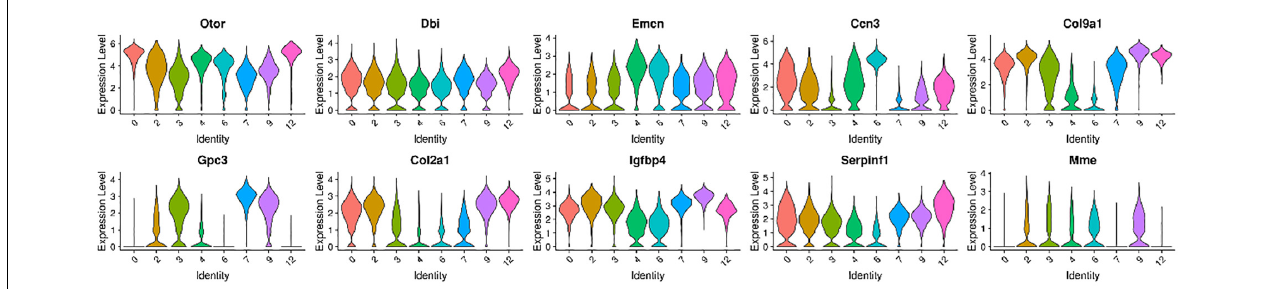
FIGURE 3 | Violin plots showing select genes that are deferentially expressed in the GER cluster 0, 3, 4, and 6 with the number of cells decreased from P1 to P14, and GER cluster 2, 7, 9, and 12 with the number of cells increased from P1 to P7 and degenerated and disappeared at P14 days. The Y-axis, log-normalized transcript counts. These eight clusters had similar expression characteristics.